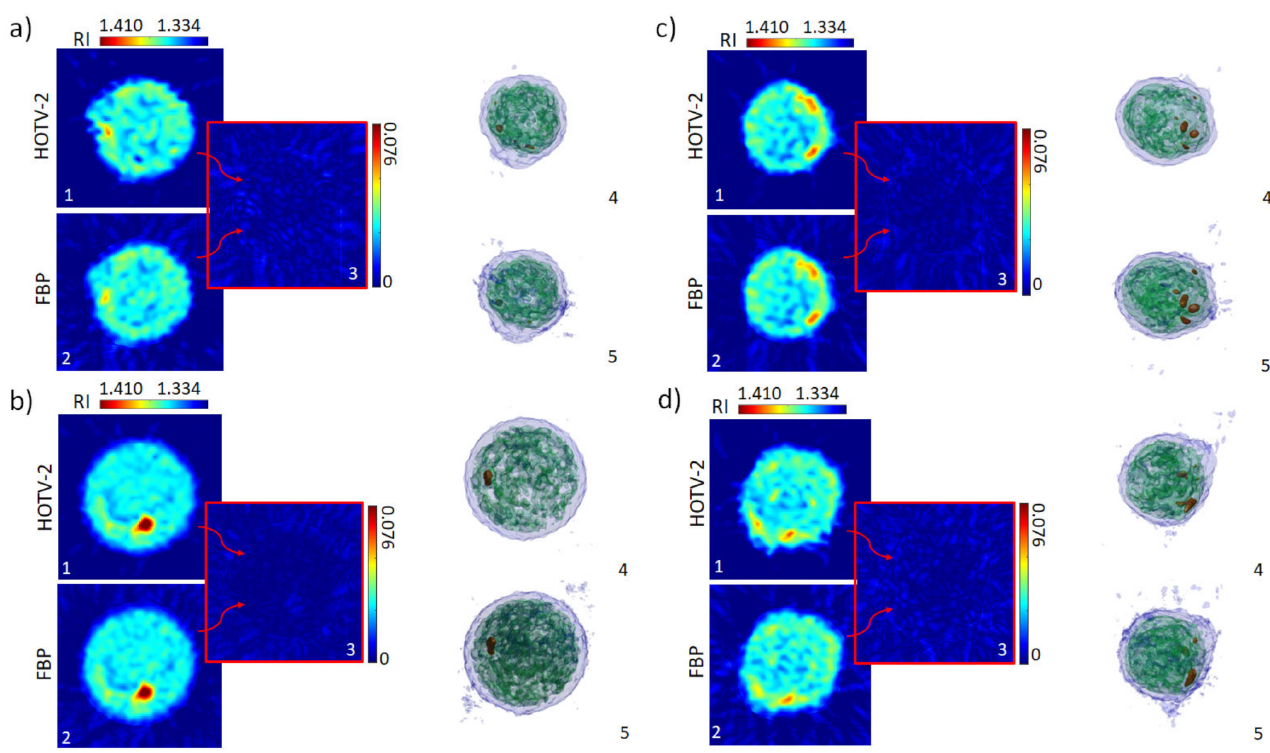
Figure 4. Tomograms of the four different monocytes examined. For every panel ( a – d ), cross-section slices from the HOTV-2 tomographic reconstruction (subfigures a1 – d1 ), cross-section slices from the FBP tomographic reconstruction (subfigures a2 – d2 ), and the absolute value of the difference between the two cross-section slices (subfigures a3 – d3 ) are presented, together with isolevel visualizations for the HOTV-2 (subfigures a4 – d4 ) and FBP reconstructions (subfigures a5 – d5 ). The length of the reference scale bar is 5 µ